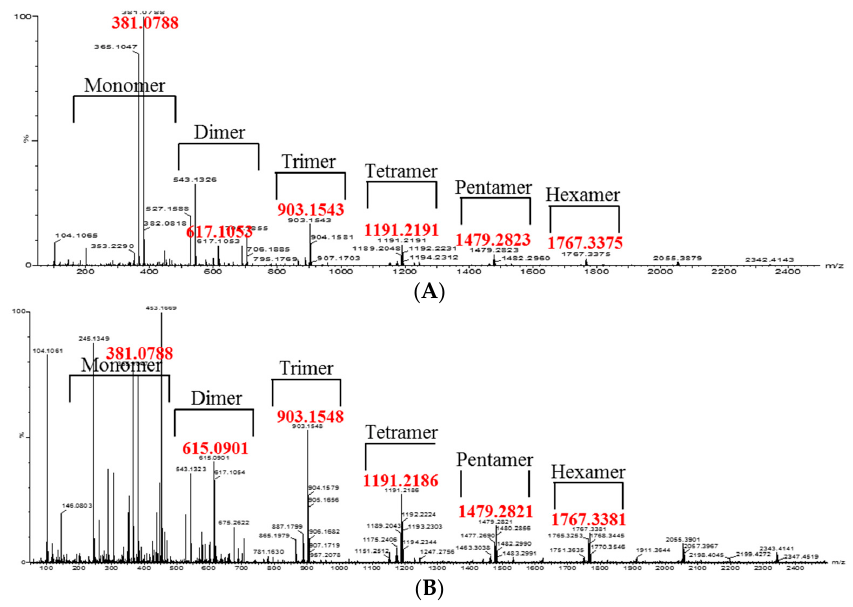
Figure 9. The synthesis of oligomeric anthocyanin from monomeric anthocyanin using glucosidase from Aspergillus niger . ( A ) Before biosynthesis; ( B ) after biosynthesis.